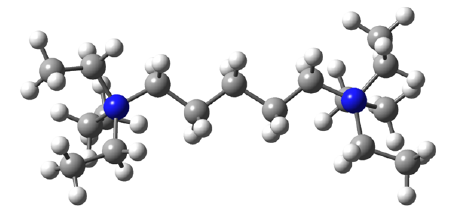
Figure 4. Structure of SDA - hexaethylpentane di- ammonium dication (blue spheres - nitrogen N + , grey - carbon, white -